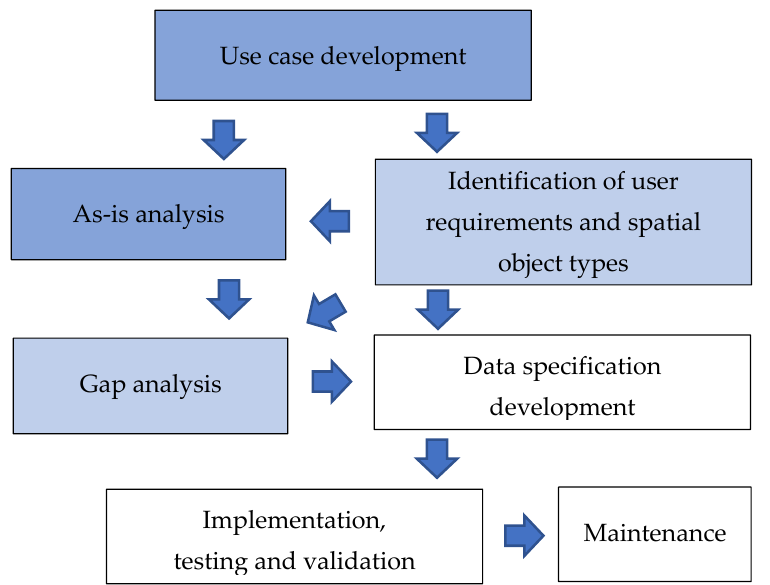
Figure 10. Process steps in the data specification cycle (adapted from [41]), text boxes in dark blue color highlight steps addressed in this paper, text boxes in light blue color highlight steps partly addressed in this paper, text boxes in white color highlight future steps.